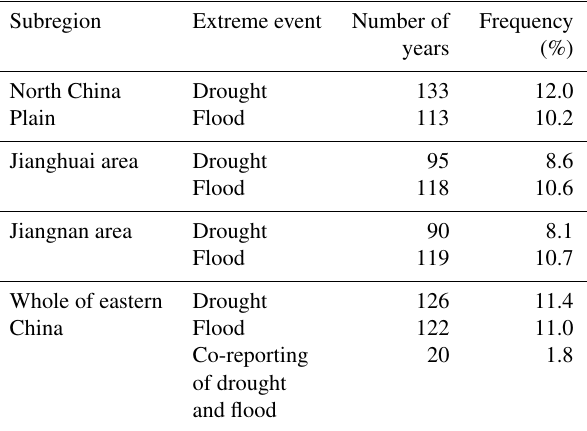
Table 1. Frequency of reported extreme drought and flood in each subregion and the whole of eastern China,